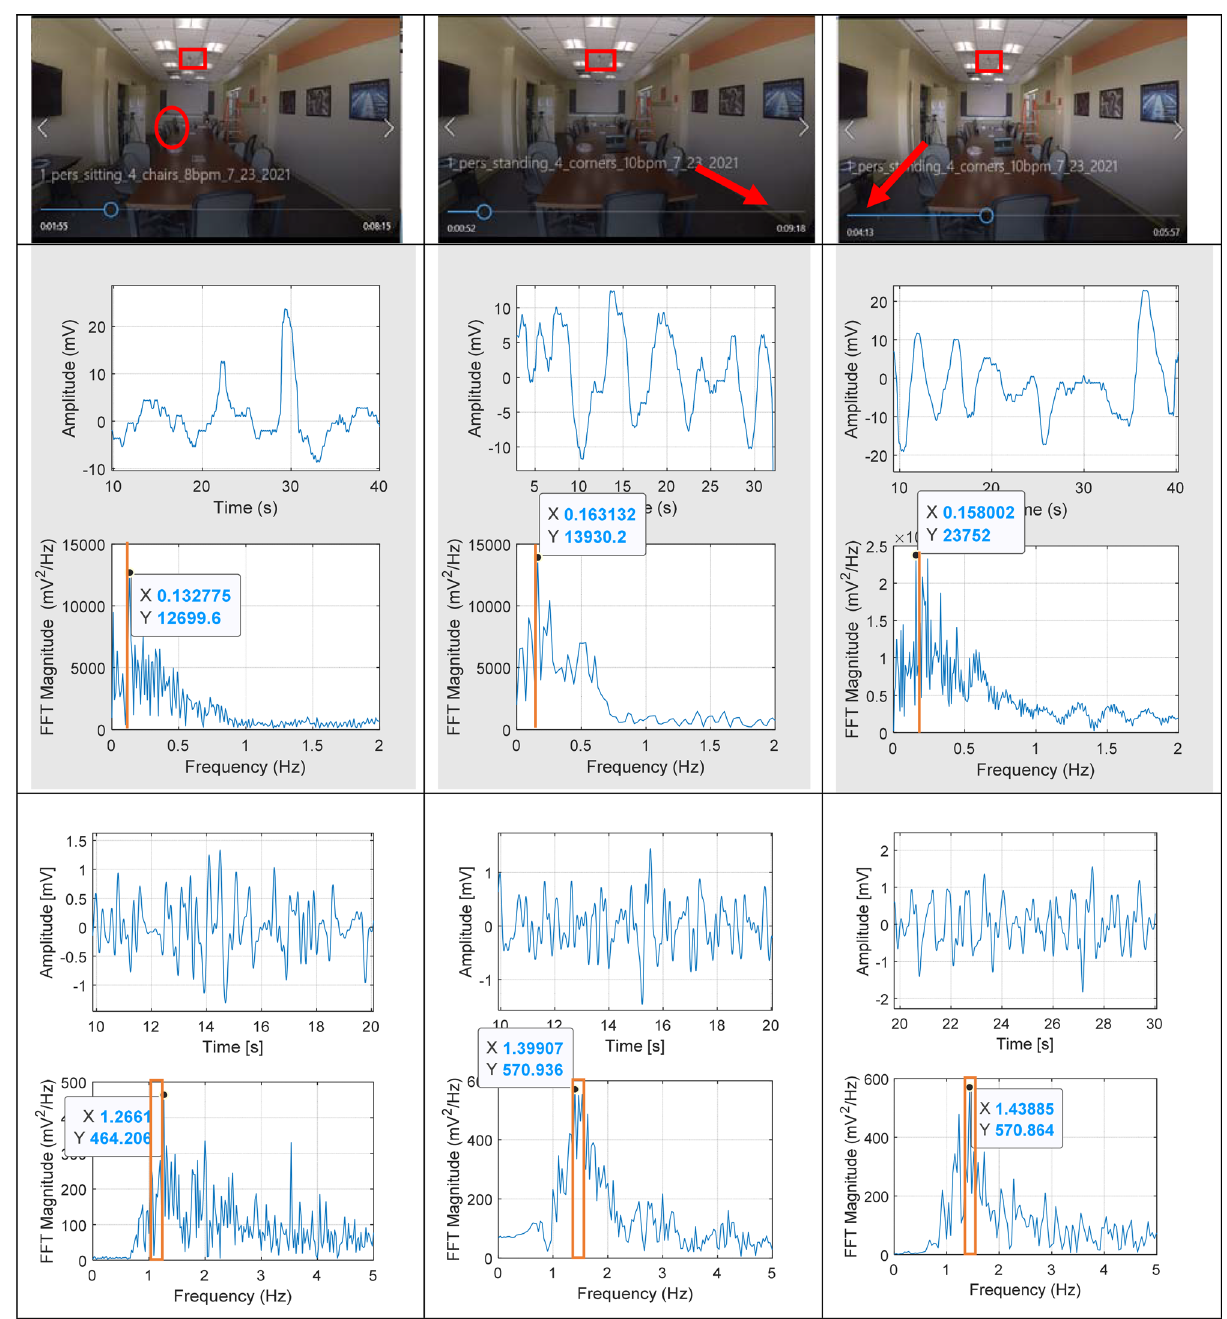
Figure 4. Physiological data examples from an occupant at three locations: the far corner of the table, and the two near corners; each column shows a different location. The top is a picture of the room, with the sensor outlined with a red box, and the occupant location circled if in the image, or an arrow to the location if out of the image. Below the picture is a sample of a signal filtered for respiratory motion: the top is a 30-s segment in the time domain, and below that is the Fast Fourier Transform (FFT) of the signal, showing it in frequency domain, with the rate at which the subject was instructed to breathe indicated with an orange line. At the bottom there are samples of signals filtered for heartbeat: the top is a 10-s segment in the time domain, and below that is the FFT of this signal, showing it in the frequency domain, with the range of rates recorded from a smart watch indicated by an orange box. (Photographs originally taken by Michelle Simkulet, and modified with permission by the